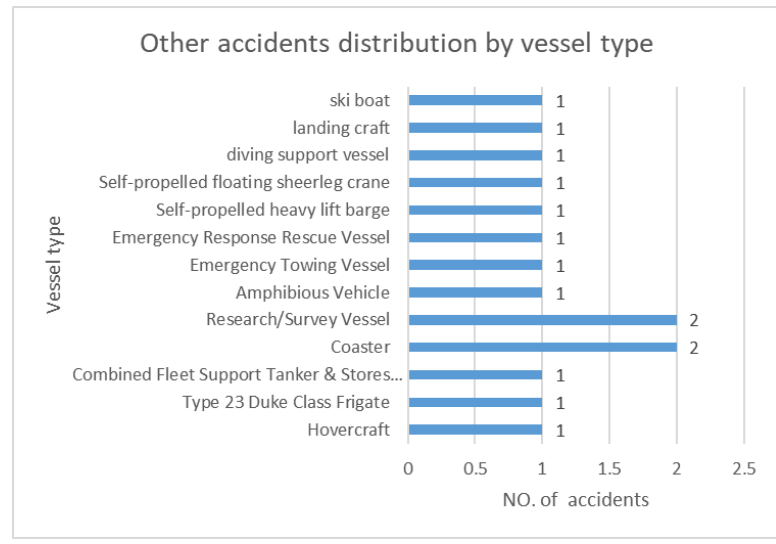
Figure 7. Other accidents distribution by vessel type.